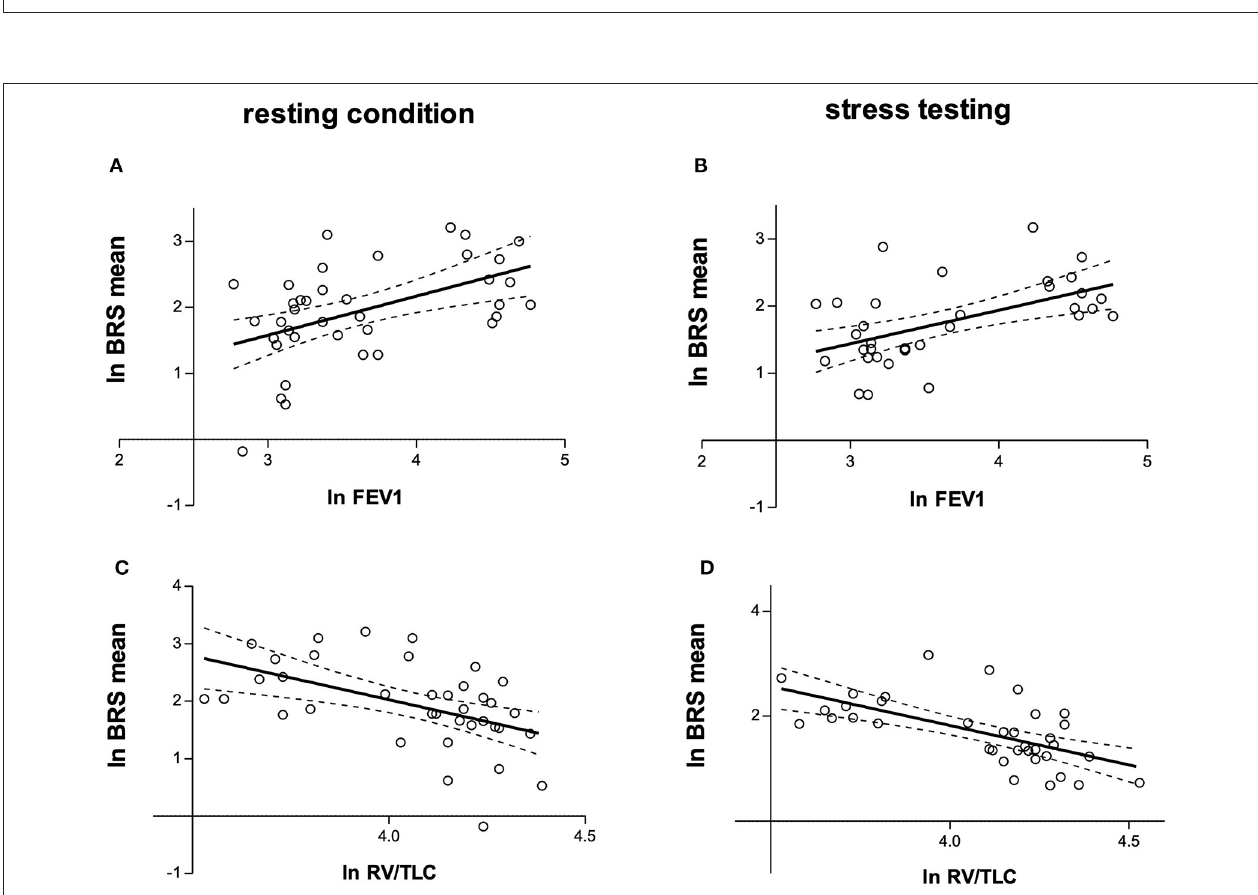
FIGURE 3 | (A) Relationship between natural logarithms of FEV 1 % and BRSmean during resting condition ( r = 0.496, P = 0.002). (B) Relationship between natural logarithms of FEV 1 % and BRSmean during mental arithmetic stress testing ( r = 0.541, P = 0.001). (C) Relationship between natural logarithms of RV/TLC and BRSmean during resting condition ( r = − 0.496, P = 0.002). (D) Relationship between natural logarithms of RV/TLC and BRSmean during mental arithmetic stress testing ( r = − 0.624, P < 0.001). lnFEV1, natural logarithm of forced expiratory volume in one second predicted (FEV 1 %); lnRV/TLC, natural logarithm of residual volume/total lung capacity; BRS, baroreceptor reflex sensitivity; lnBRSmean, natural logarithm of the mean of BRSup and